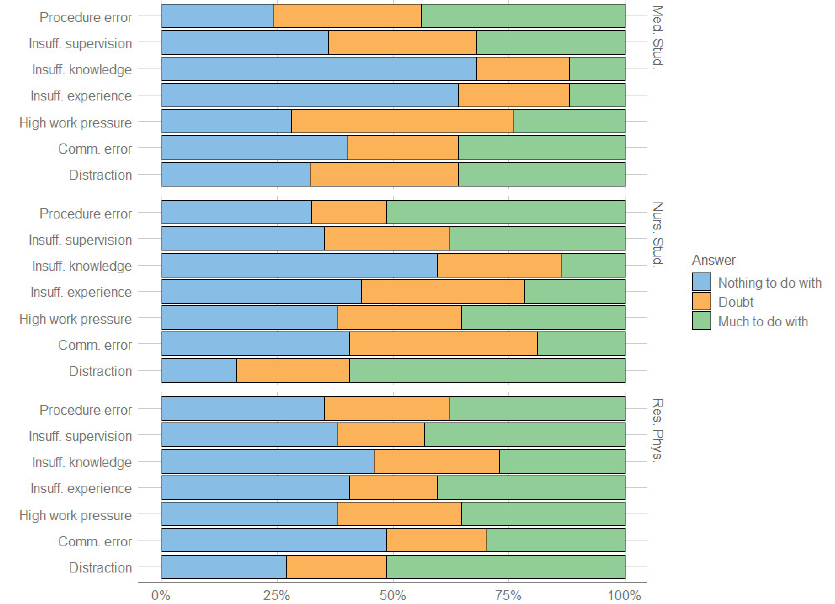
Figure 1. Students’ opinions about the causes of PSIs.